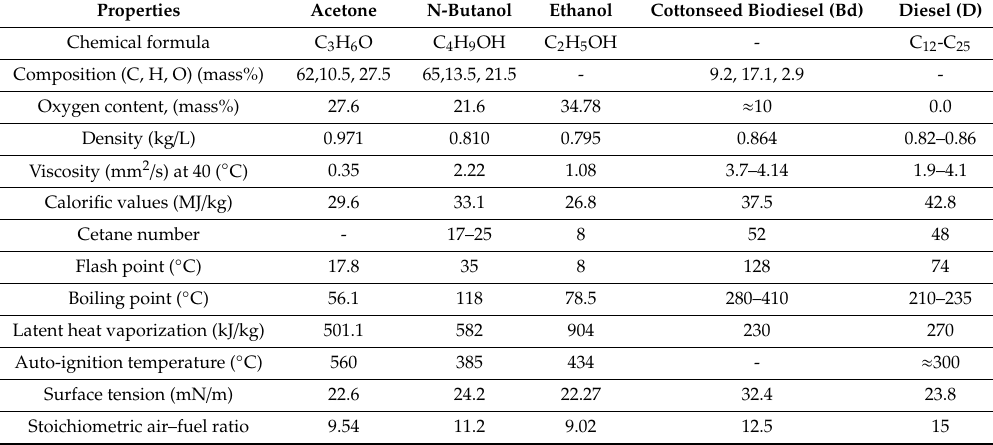
Table 1. Fuel properties